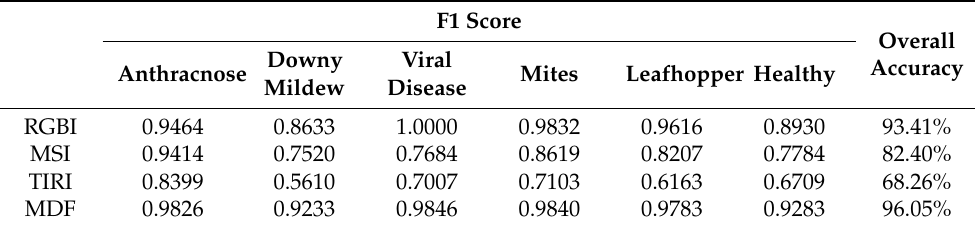
Table 6. Overall accuracy and F1 score of RGBI, MSI, TIRI, and MDF